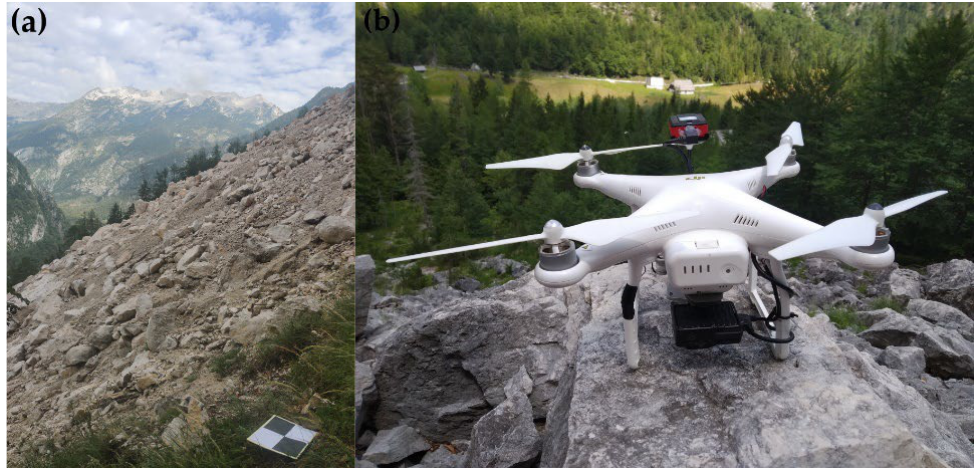
Figure 4. ( a ) An example of the GCP target and ( b ) Parrot Sequoia camera mounted on DJI Phantom 3.